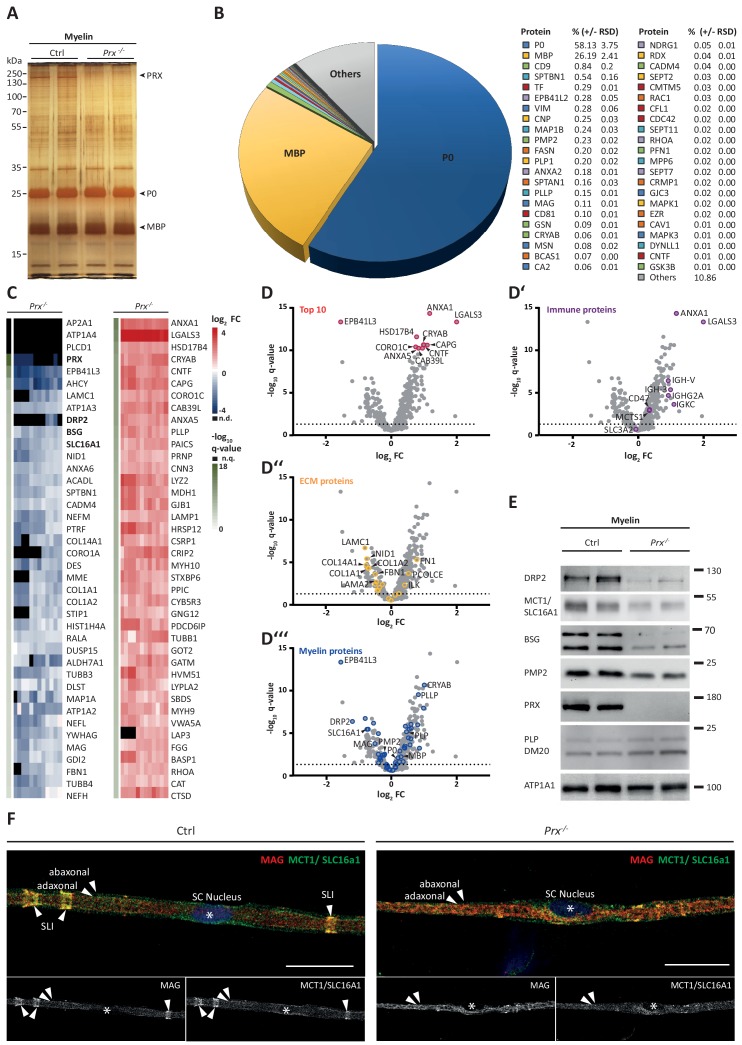
Molecular analysis of myelin in the Prx-/- mouse model of CMT4F.(A) Myelin purified from sciatic nerves dissected from Prx-/- and control mice at P21 was separated by SDS-PAGE (0.5 µg protein load) and proteins were visualized by silver staining. Bands constituted by the most abundant myelin proteins (MPZ/P0, MBP, PRX) are annotated. Note that no band constituted by PRX was detected in Prx-/- myelin and that several other bands also display genotype-dependent differences in intensity. Gel shows n = 2 biological replicates representative of n = 3 biological replicates. (B) The relative abundance of proteins in myelin purified from Prx-/- sciatic nerves as quantified by MSE is given as percent with relative standard deviation (% +/- RSD). Note the increased relative abundance of MPZ/P0 and MBP compared to wild-type myelin (see Figure 2) when PRX is lacking. Mass spectrometric quantification based on 3 biological replicates with 4 technical replicates each (see Figure 5—source data 1). (C,D) Differential proteome analysis by DRE-UDMSE of myelin purified from Prx-/- and wild-type mice. Mass spectrometric quantification based on 3 biological replicates per genotype with 4 technical replicates each (see Figure 5—source data 2). (C) Top 40 proteins of which the abundance is reduced (blue) or increased (red) in peripheral myelin purified from Prx-/- compared to wild-type mice with the highest level of significance according to the -log10 transformed q-value (green). In the heatmaps, each horizontal line corresponds to the fold-change (FC) of a distinct protein compared to its average abundance in wild-type myelin plotted on a log2 color scale. Heatmaps display 12 replicates, that is 3 biological replicates per genotype with 4 technical replicates each. (D-D‘‘‘) Volcano plots representing genotype-dependent quantitative myelin proteome analysis. Data points represent quantified proteins in Prx-/- compared to wild-type myelin and are plotted as the log2-transformed fold-change (FC) on the x-axis against the -log10-transformed q-value on the y-axis. Stippled lines mark a -log10-transformed q-value of 1.301, reflecting a q-value of 0.05 as significance threshold. Highlighted are the datapoints representing the Top 10 proteins displaying highest zdist values (Euclidean distance between the two points (0,0) and (x,y) with x = log2(FC) and y = -log10(q-value) (red circles in D), immune-related proteins (purple circles in D‘), proteins of the extracellular matrix (ECM; yellow circles in D‘‘) and known myelin proteins (blue circles in D‘‘‘). n.d., not detected; n.q., no q-value computable due to protein identification in one genotype only. Also see Figure 5—figure supplement 1. (E) Immunoblot of myelin purified from Prx-/- and control sciatic nerves confirms the reduced abundance of DRP2, SLC16A1/MCT1, BSG and PMP2 in Prx-/- myelin, as found by differential DRE-UDMSE analysis (in C,D). PRX was detected as genotype control; PLP/DM20 and ATP1A1 serve as markers. Blot shows n = 2 biological replicates per genotype. (F) Teased fiber preparations of sciatic nerves dissected from Prx-/- and control mice immunolabelled for MAG (red) and SLC16A1 (green). Note that SLC16A1 co-distributes with MAG in Schmidt-Lanterman incisures (SLI) in control but not in Prx-/- nerves, in accordance with the reduced abundance of SLC16A1 in Prx-/- myelin (C–E). Also note that, in Prx-/- myelin, SLI were largely undetectable by MAG immunolabeling.Figure 5—source data 1.Label-free quantification of proteins in PNS myelin fractions from Prx-/- mice by MSE Identification and quantification data of detected myelin-associated proteins.Tryptic peptides derived from four technical replicates (replicate digestion and replicate injection) per three biological replicate (20 sciatic nerves pooled from 10 animals) were analyzed by LC-MS (12 runs in total). Proteins (FDR < 1%; 2 peptides/protein) and peptides (FDR < 1%;≥7 amino acids) were identified by database search against the UniprotKB/SwissProt mouse database using PLGS. Data were post-processed with the software package ISOQuant to calculate absolute in-sample amounts for each detected protein based on the TOP3 approach. Reported abundance values are defined as the relative amount of each protein in respect to the sum over all detected proteins (ppm: parts per million (w/w) of total protein). Typical contaminant proteins like keratins were filtered. → sheet 1: protein identification details → sheet 2: Prx-/- myelin proteome by MSE.Figure 5—source data 2.Label-free quantification of proteins in PNS myelin fractions from WT and Prx-/- mice by DRE-UDMSE Identification and quantification data of detected myelin-associated proteins by DRE-UDMSE.For each genotype, tryptic peptides derived from four technical replicates (replicate digestion and replicate injection) per three biological replicate (20 sciatic nerves pooled from 10 animals) were analyzed by LC-MS (24 runs in total). Proteins (FDR < 1%; 2 peptides/protein) and peptides (FDR < 1%;≥7 amino acids) were identified by database search against the UniprotKB/SwissProt mouse database using PLGS. Data were post-processed with the software package ISOQuant to calculate absolute in-sample amounts for each detected protein based on the TOP3 approach. Reported abundance values are defined as the relative amount of each protein in respect to the sum over all detected proteins (ppm: parts per million (w/w) of total protein). Typical contaminant proteins like keratins were filtered. The -log10-transformed q-value was plotted against the log2-transformed fold change to obtain the volcano plot shown in Figure 5D. As no imputation of missing values was performed, proteins exclusive for only one of the conditions do not appear in the volcano plot, but are appended at the end of the list. Criteria for statistically significant regulation were as follows: fold change of at least 1.5 and q-value below 0.05. → sheet 1: protein identification details → sheet 2: comparison of WT vs. Prx-/- myelin proteome by DRE-UDMSE.